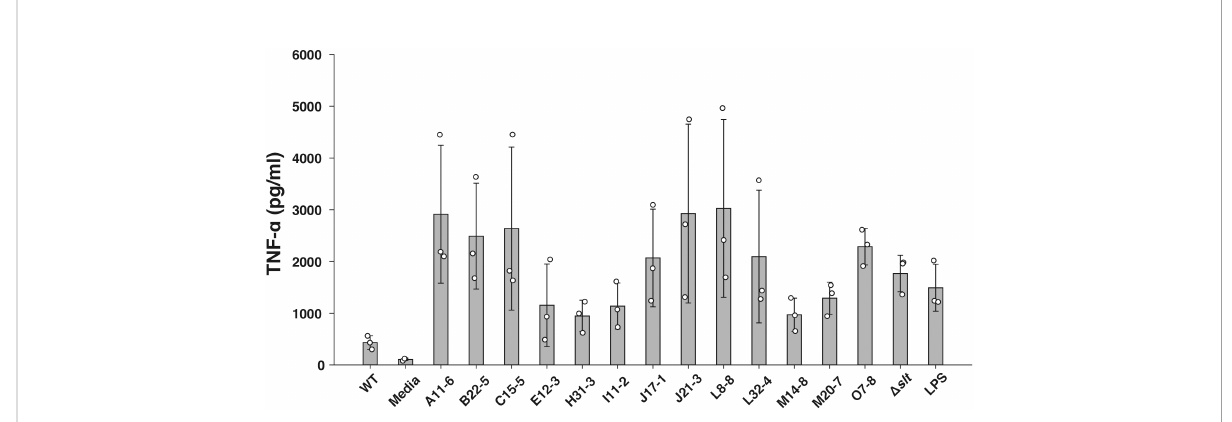
FIGURE 1 Screening of the F. novicida transposon mutant library using a TNF- a ELISA assay. U937 cells were infected with F. novicida transposon mutants at an MOI of 1 or stimulated with 100 ng/ml of E . coli LPS- or same volume BHIc-containing medium. After 5 h of infection, TNF- a released into the cell supernatant was measured by ELISA. Data shows averages and standard deviations from three independent experiments. Transposon mutant strains that exhibited a 1.5-fold increase in TNF- a production compared with the wild-type strain are